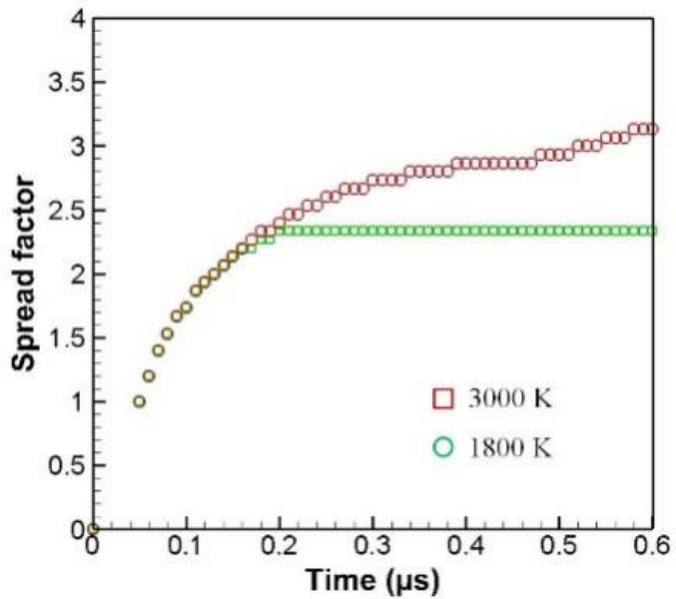
Figure 8. Spread factor evolution for Ni drop at different initial temperatures.